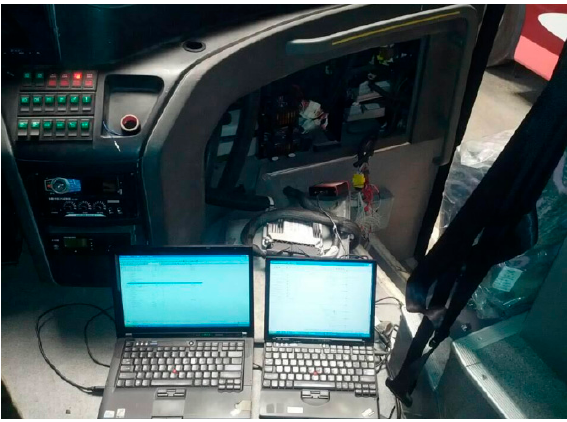
Figure 18. Data collection in vehicle tests.